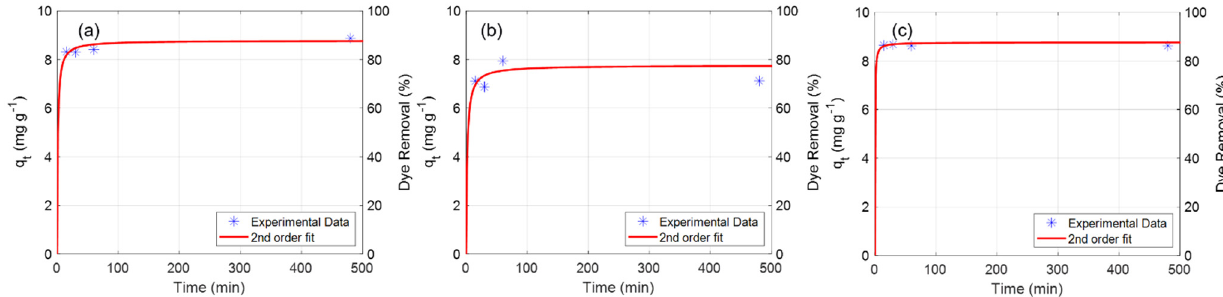
Figure 3. Kinetics of dye uptake with ( a ) modified bentonite, ( b ) talc and ( c ) calcium carbonate using 100 ppm dye solutions over the first 500 min of contact time. Data shown in terms of relative adsorption capacity, q t (in mg g − 1 ) on left-hand axes, and dye removal percent on right-hand axes.